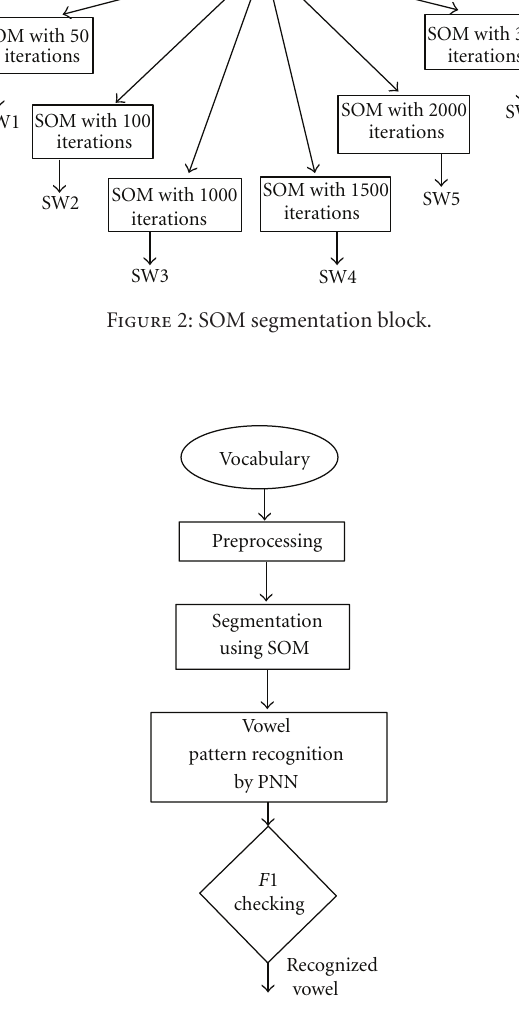
Figure 3: Process logic of the proposed algorithm.